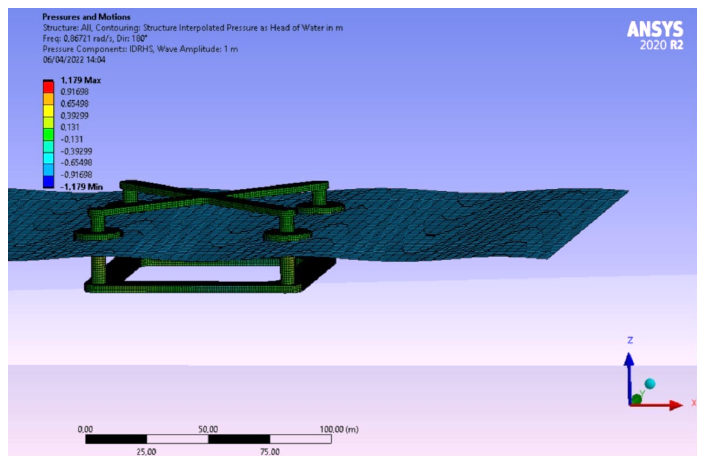
Figure 12. ANSYS ‘Pressure and motion’ workspace output for hybrid